Question: How would you classify this visualization?
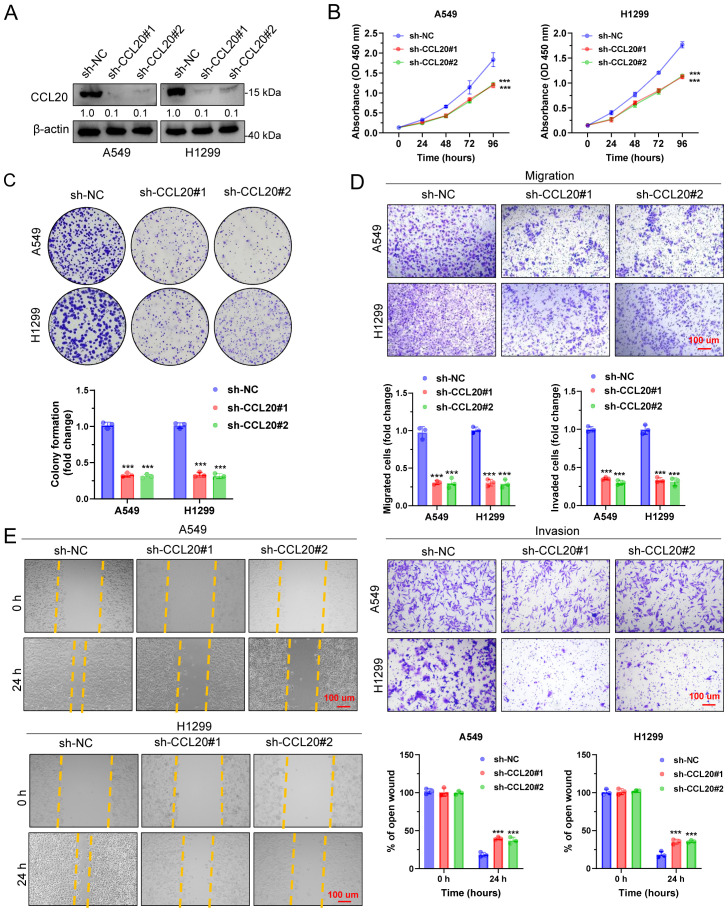
Answer: bar